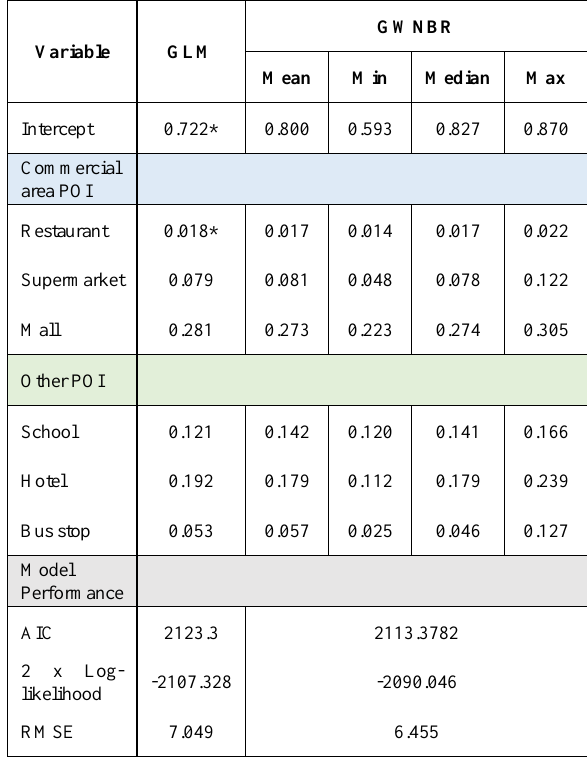
Table 2 . Model comparison of delivery motorcycle crashes during the weekday.